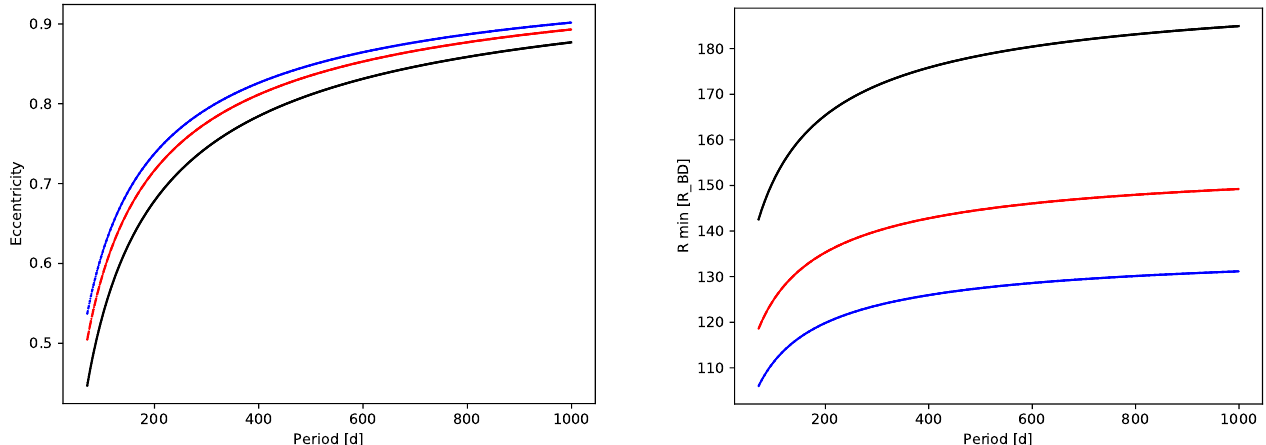
Fig. 5.— Left: Eccentricity as function of period for a 1.3hr long eclipse of a 0.06 M (blue) companion, assuming an object radius of 0.13 R (cid:12) and the eclipse occurring at periastron. Right: Minimum distance between the two objects in units of the object radius (0.13 R (cid:12) ). planet companion around a brown dwarf is not implau-